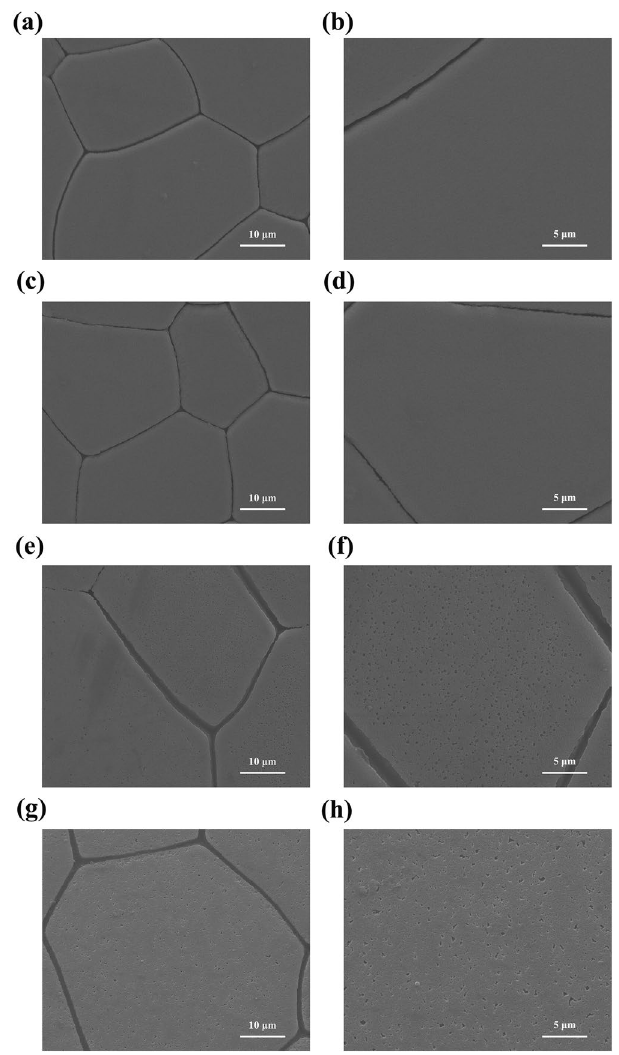
Figure 3. Effects of the inhibition of PfY2 on regulating the prismatic layer of inner shell. ( a , b ) SEM images of the normal shell prismatic layers from oysters injected with water. ( c , d ) SEM images of the prismatic layers in GFP-injected group shells. ( e , f ) SEM images of the prismatic layers in 60 μ g PfY2 dsRNA injected group shells. ( g , h ) SEM images of the prismatic layers in 120 μ g PfY2 dsRNA injected group shells. ( b , d , f , h ) showed an enlargement of ( a , c , e , g )